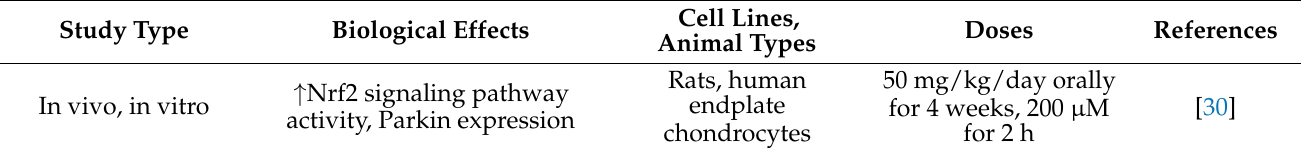
Table 8. Effects of polydatin on skeletal